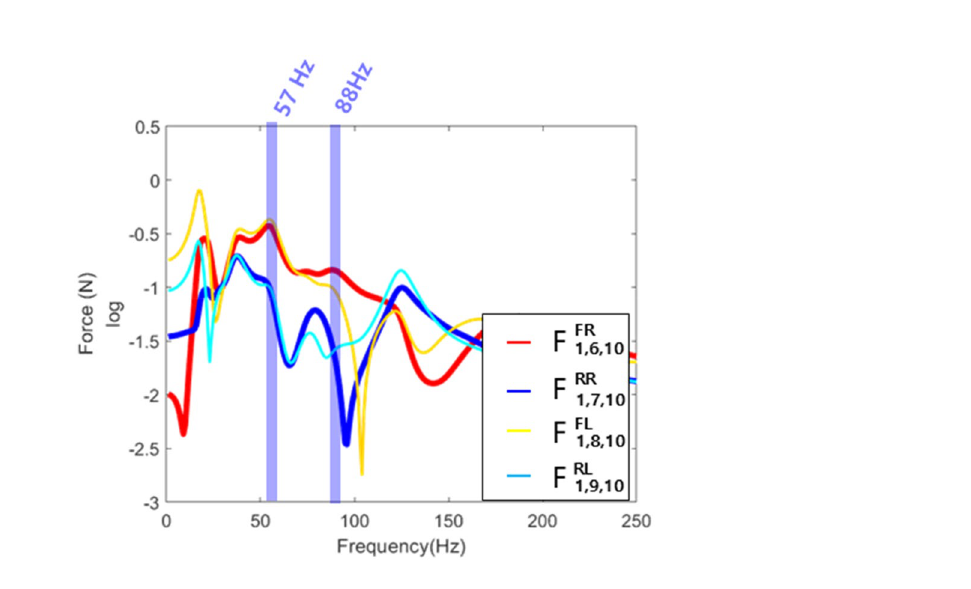
Figure 6. Transmitted force at the final response